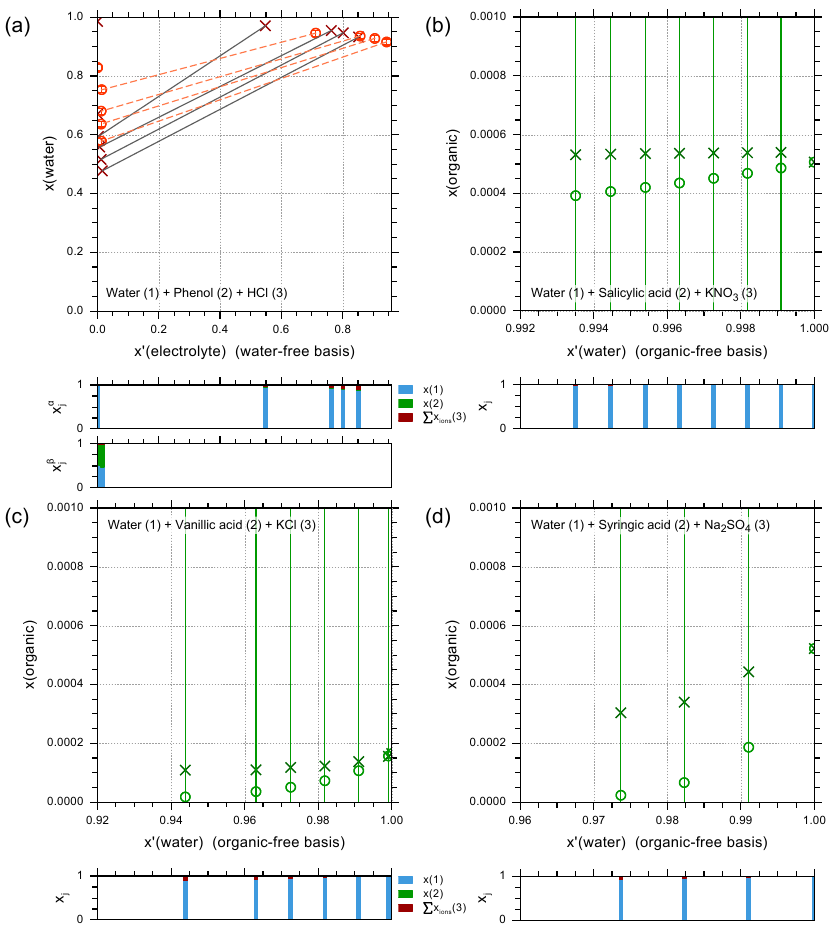
Fig. 13. Ternary systems containing multifunctional phenolic compounds. Experimental values are given by symbols ( ) and respective AIOMFAC calculations by ( ). (a) LLE of water (1) +phenol (2) +HCl (3) at 285K. LLE composition measurements by Schreinemakers and van den Bos (1912). (b) Solubility limits of salicylic acid in aqueous KNO 3 solutions at 308K. Measurements by Sugunan and Thomas (1995). (c) Solubility limits of vanillic acid in aqueous KCl solutions at 298K. Measurements by Noubigh et al. (2007b). (d) Solubility limits of syringic acid in aqueous Na 2 SO 4 solutions at 298K. Measurements by Noubigh et al.